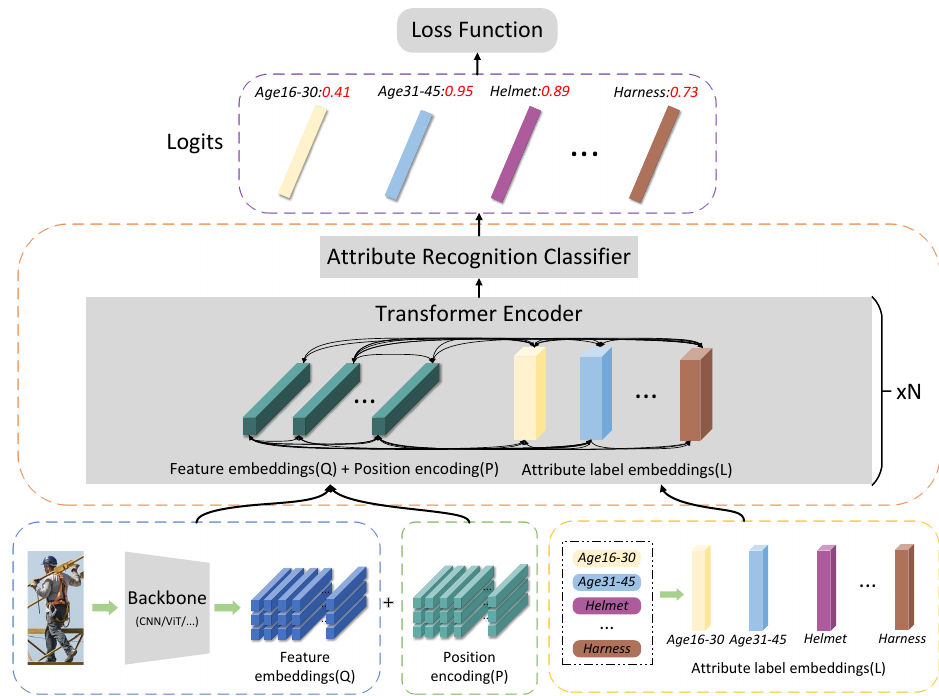
Figure 3. The framework of our proposed method. We use the transformer encoder to model the relationship between feature embeddings and attribute label